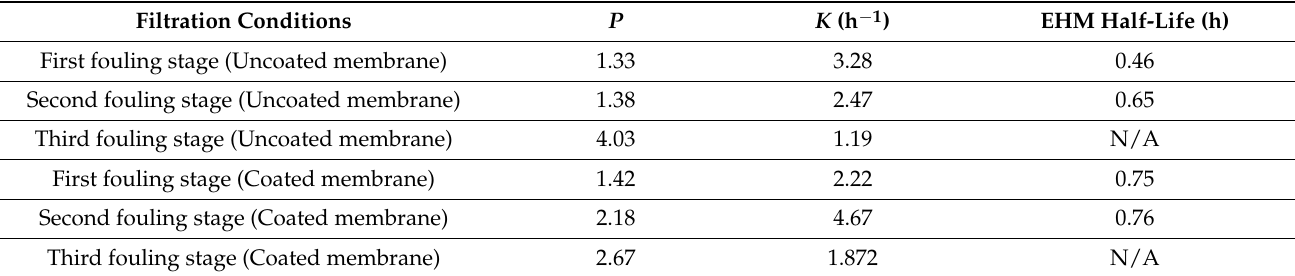
Table 14. EHM parameters for the regressions obtained in Example